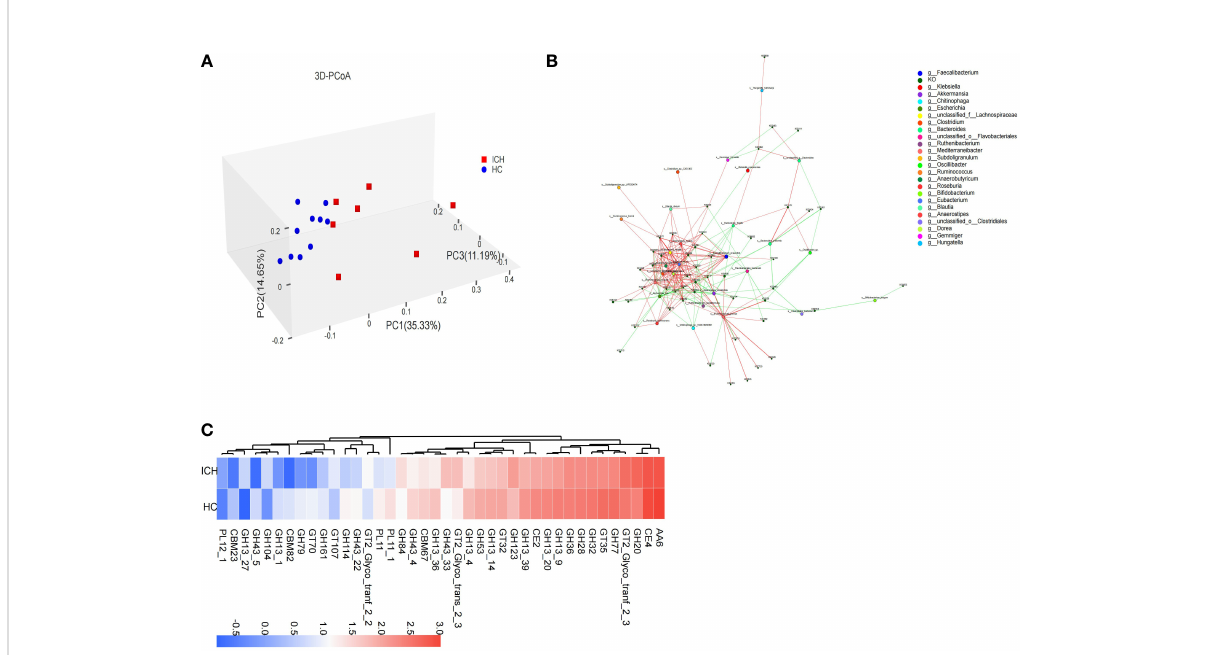
FIGURE 3 Functional characteristics of fecal microbiota in ICH. (A) PCoA (3D) based on Bray – Curtis difference index shows functional (KO) ( b ) diversity (PERMANOVA, P=0.002) between samples; (B) The correlation network diagram was constructed by the bacteria in the fi rst 30 abundance and the KOs in the fi rst 50 abundance, the red line represents positive correlation and the green line represents negative correlation (C) The difference in abundance of the CAZy family between the ICH and HC